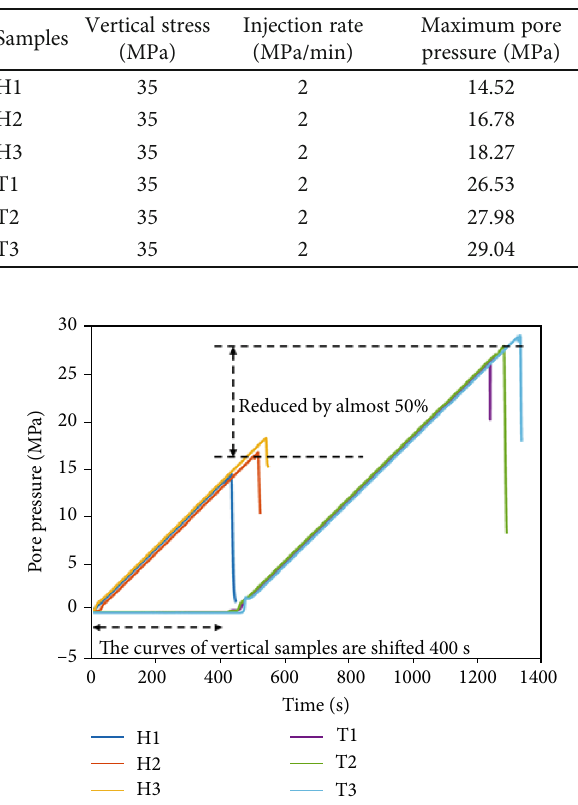
Table 2: Vertical stress and pore pressure loading on the six shale samples.